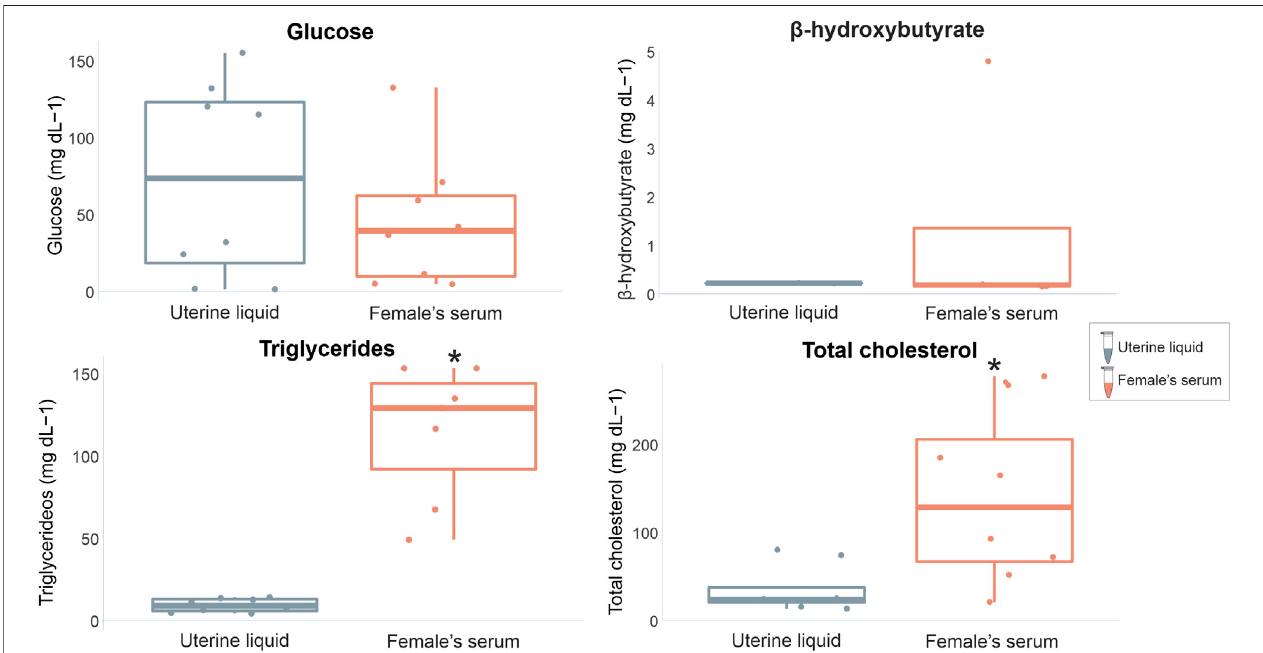
FIGURE 3 | Graphical representation of P. horkelii energetic marker concentrations in the uterine liquid (UL) (grey boxplots) and serum of pregnant females (light pink boxplots).